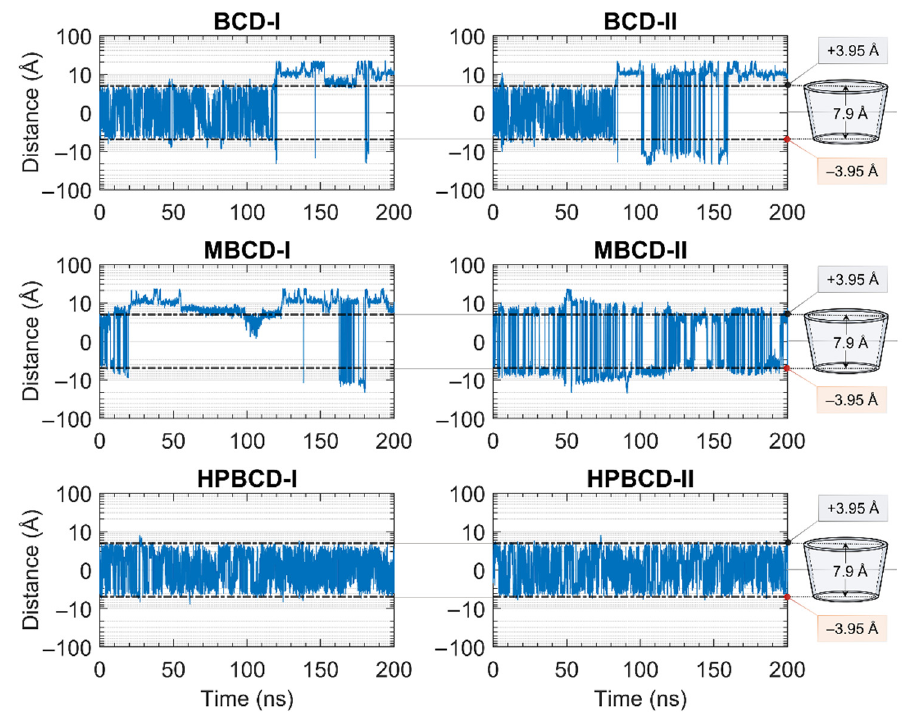
Figure 2. Plots of the distance between the center of mass of plumbagin and BCDs during 200 ns MD simulations. The y-axis of all subplots is presented in a logarithmic scale for a clearer presentation. The black horizontal dashed lines indicate the distances from the center of mass of BCD core structure to the wider rim and narrow rim with the distances labeled as +3.95 and − 3.95 Å, respectively. The truncated cone diagrams on the right represent the total vertical dimension of BCD’s core structures, without substituted functional